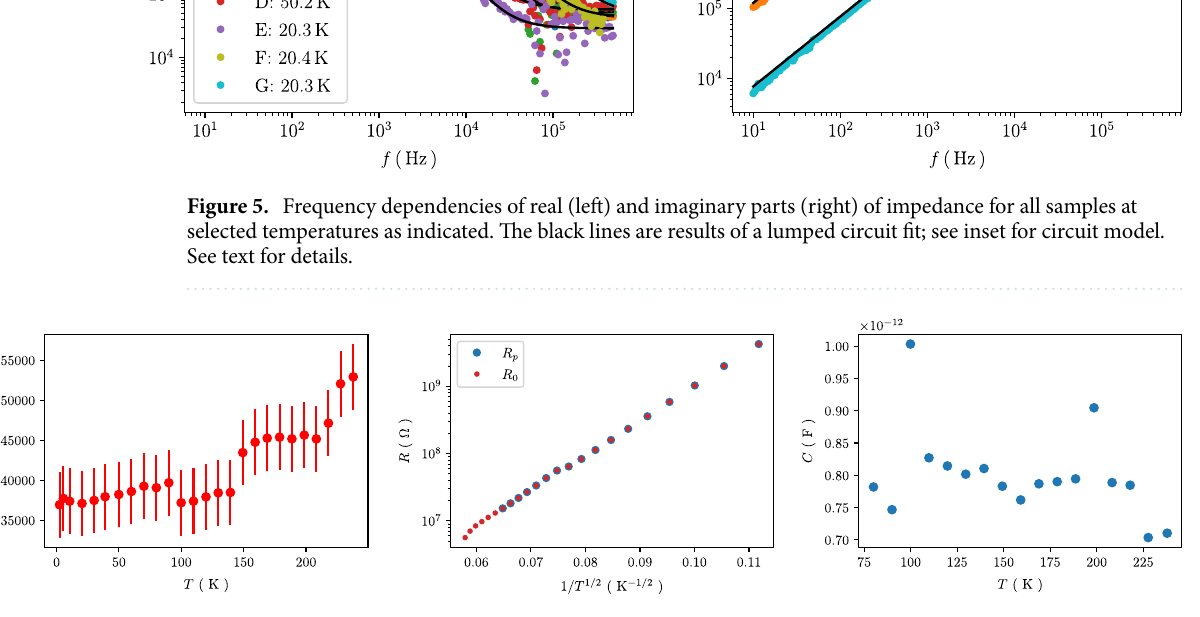
Figure 6. Temperature dependence of lumped circuit fit parameters for sample A. R 1 and R 0 are taken directly from the frequency dependence of the real part of the impedance. C is a fit parameter following the lumped circuit model, as detailed in the text. R p = R 0 − R 1 . The error bars for R 1 correspond to the standard deviation of R 1 taken from the real part of the impedance at 80 K for f ≥ 0.2 MHz where saturated behavior is clearly